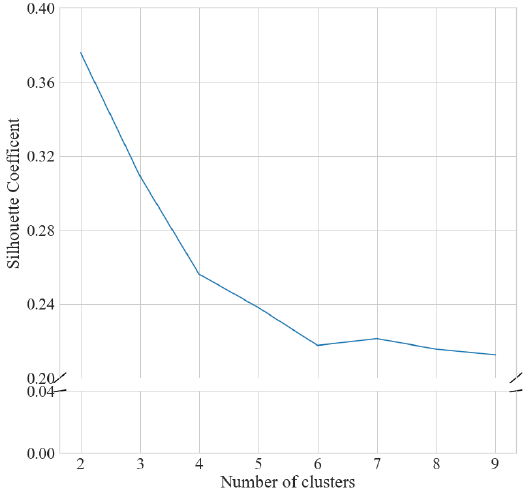
Figure 4. Silhouette analysis for k-means clustering of weekly step behaviour.